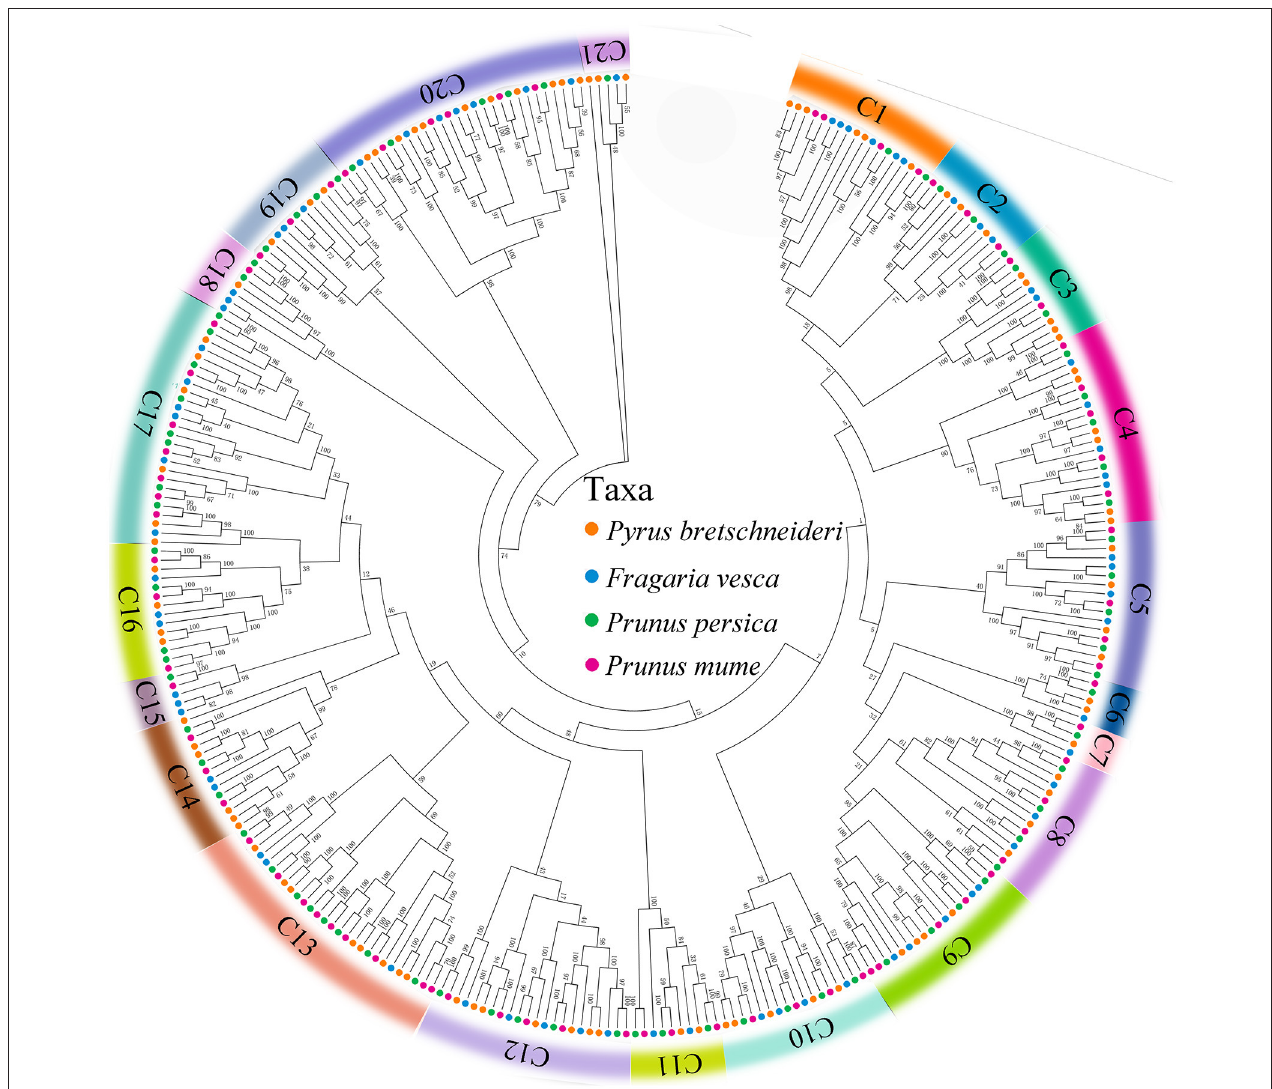
FIGURE 1 | Phylogenetic relationships and subfamily designations in PRX proteins from Pyrus bretschneideri Rehd, Prunus mume, Prunus persica , and Fragaria vesca . Theneighbor-joining tree includes 94 PRX proteins from Pyrus bretschneideri Rehd, 76 from Prunus mume , 74 from Prunus persica and 73 from Fragaria vesca. These proteins were divided into 21 Clades (C1–C21), and were represented by different colors, respectively.